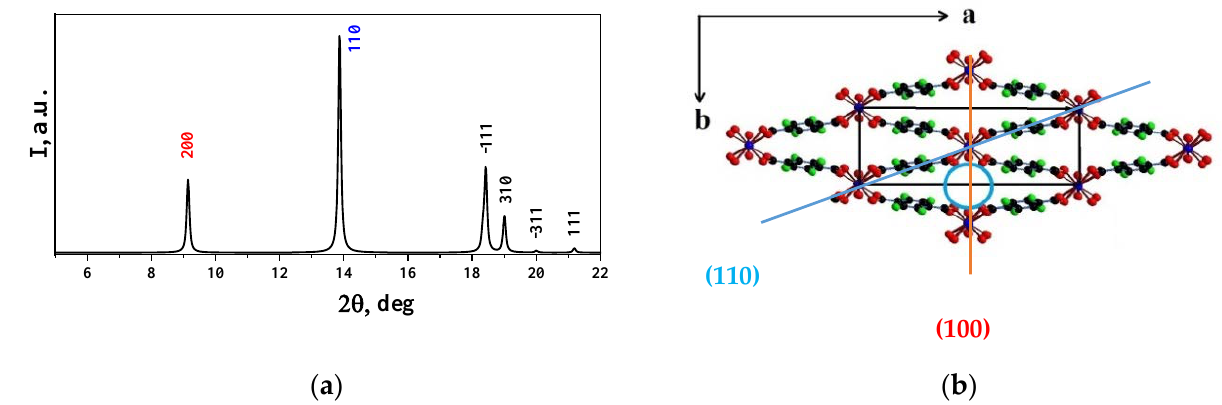
Figure 4. Structure IV (sp.gr. C 1 2/c 1; z = 4): theoretical diffraction pattern ( a ), structure projected onto the ( b ) XY plane.